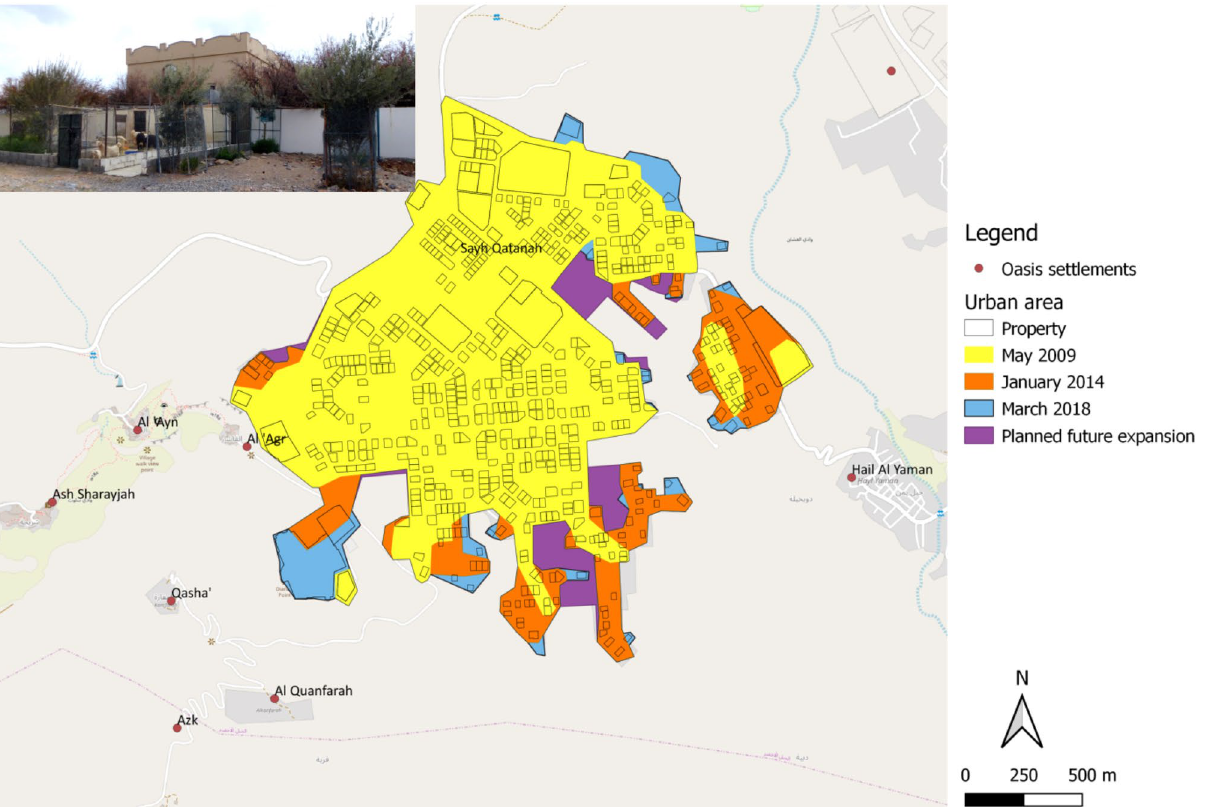
Figure 3. Physical expansion of the town of Sayh Qatanah (2000 m a.s.l.) on the Sayq Plateau of Al Jabal Al Akhdar (Oman) in 2009, 2014 and 2018. The image on the upper left shows a typical private house with